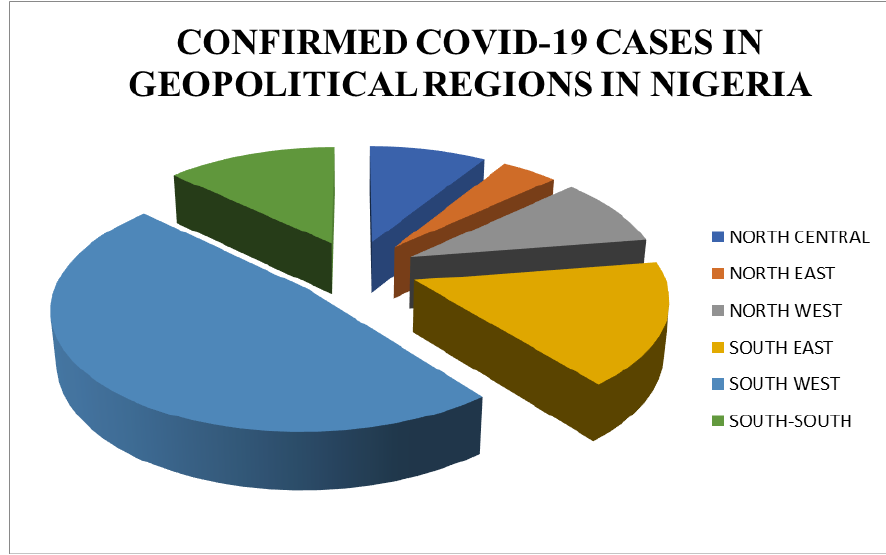
Figure 2. Confirmed Cases of COVID-19 in Geopolitical regions of Nigeria. Table 2. Prevalence of COVID-19 according to the Geographical Zones in Nigeria.